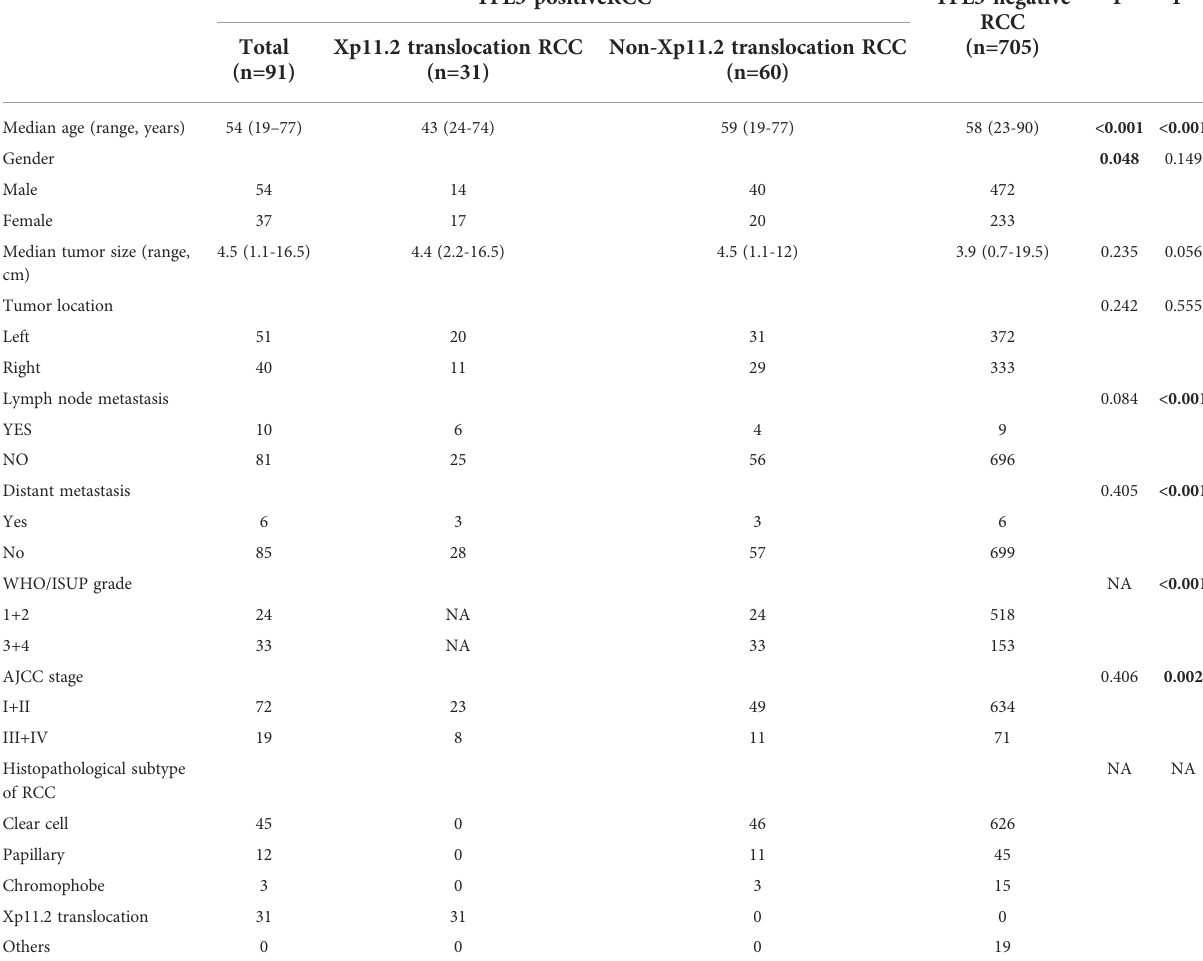
TABLE 1 Clinicopathological characteristics of the 796 patients with RCC.